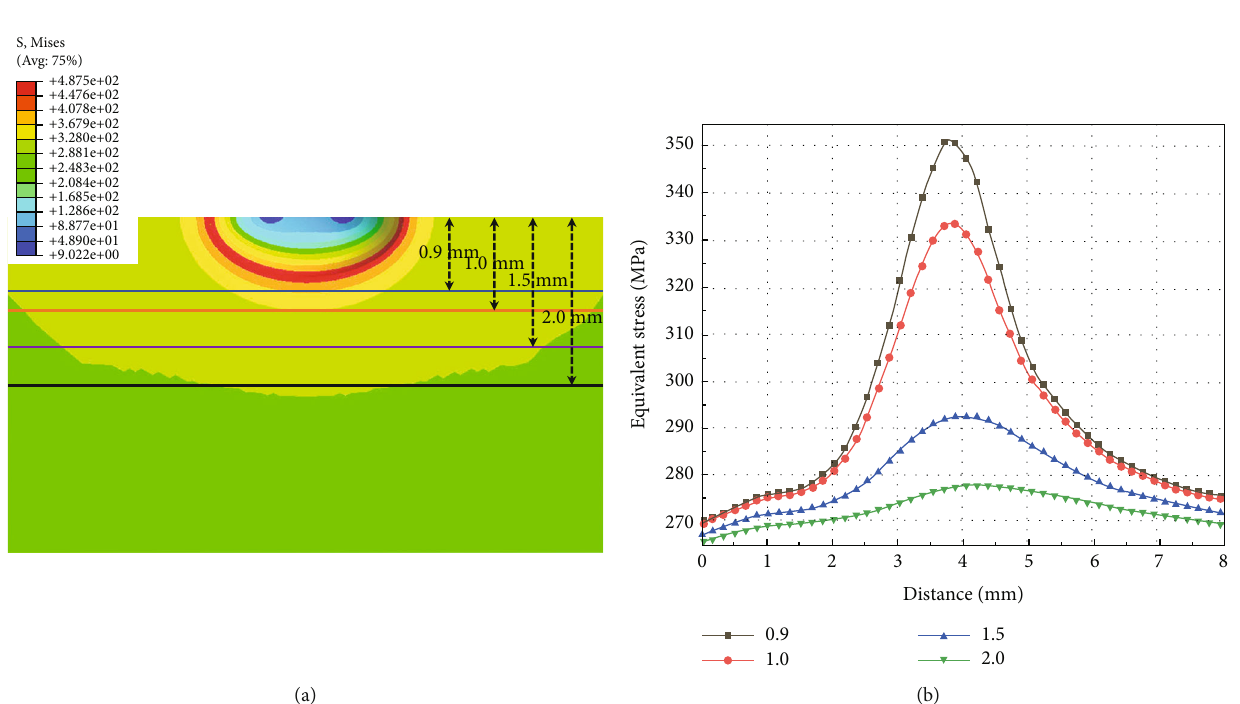
Figure 12: Stress distribution in the FEM results: (a) stress contour near the hole; (b) stress curves of traces in